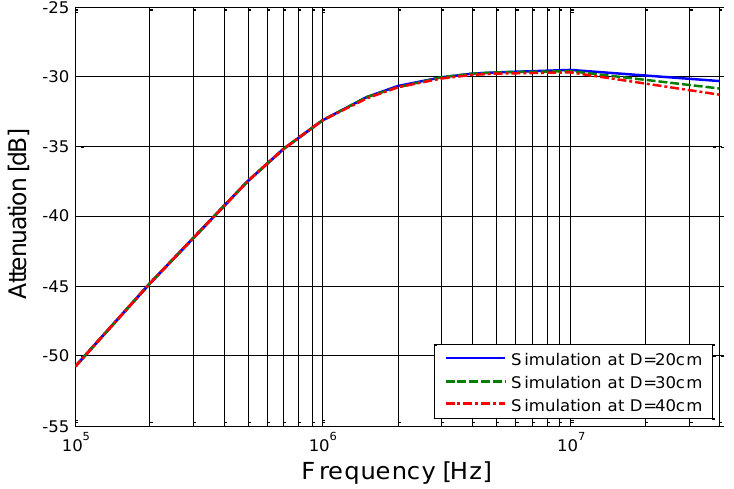
Figure 11. Simulation results corresponding to the different signal transmission distances and